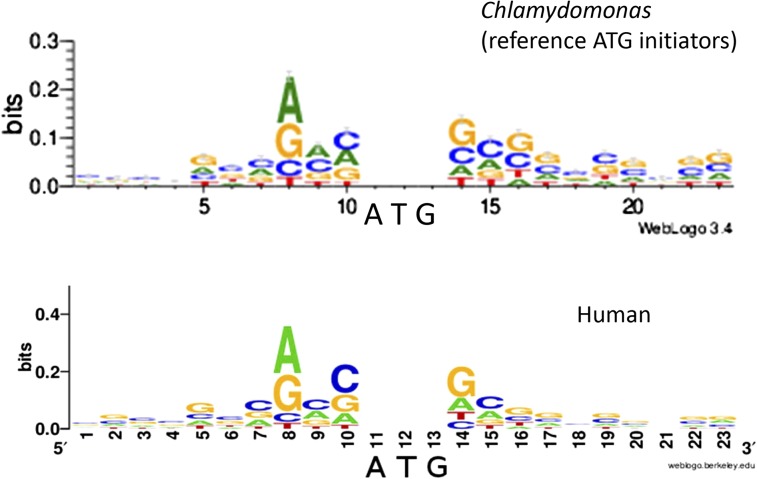
Kozak-like consensus sequence around Chlamydomonas reference initiator ATGs. All 19,228 sequences were fed to the online WebLogo tool (http://weblogo.threeplusone.com) (Crooks et al., 2004). A comparable plot for human mRNAs was downloaded from Wikipedia (https://en.wikipedia.org/wiki/ File:Human_Kozak_context._Version_2).